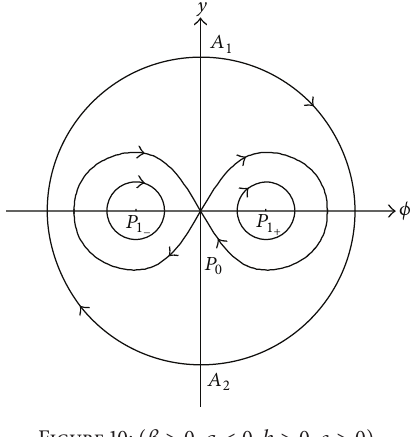
Figure 10: ( 𝛽 > 0 , 𝑎 < 0 , 𝑏 > 0 , 𝑐 > 0 ).